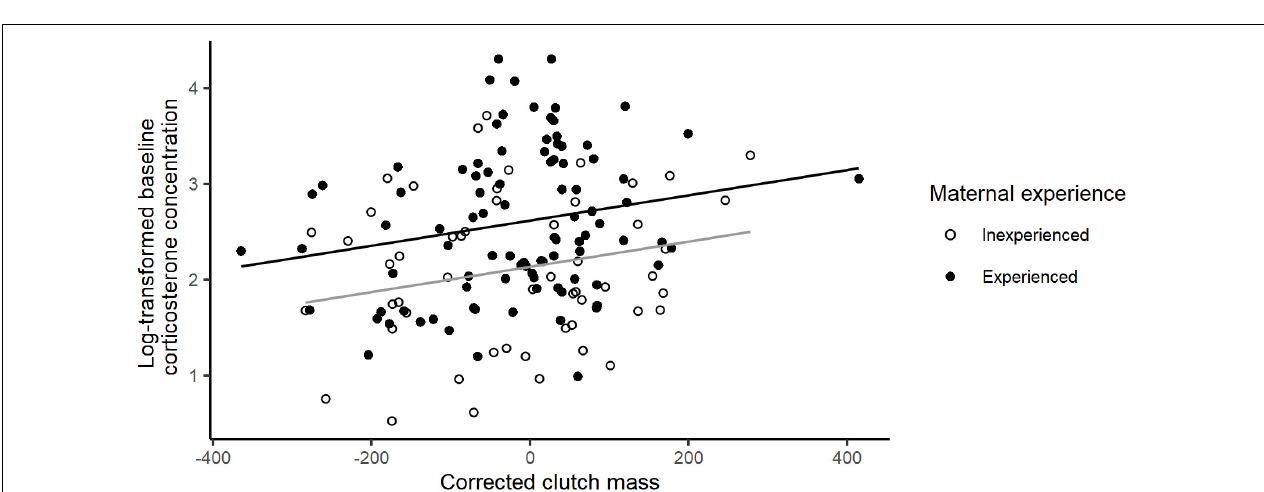
FIGURE 1 | Relationship between baseline (A) prolactin and (B) log-transformed corticosterone levels of incubating female eiders and island-specific nest predation risk. Black dots correspond to island-specific mean hormone levels and bars account for the standard error.